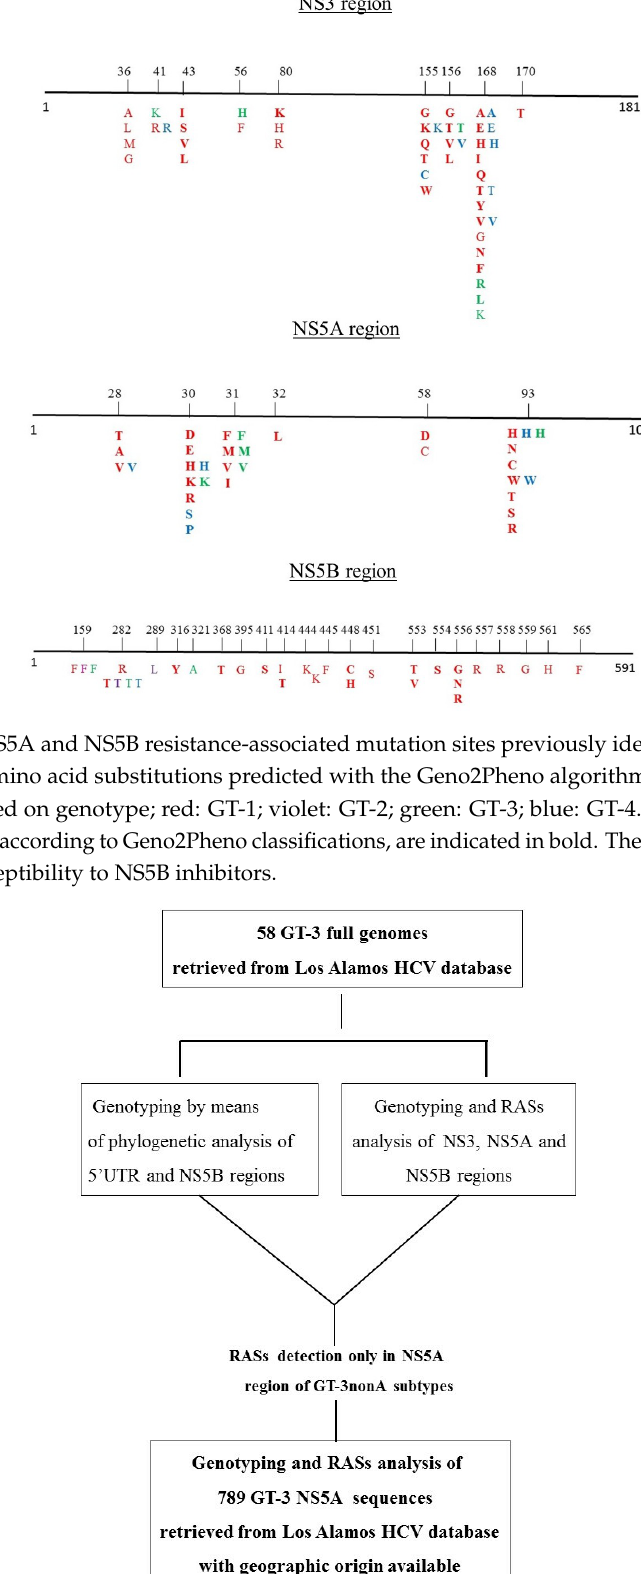
Figure 2. Schematic representation of the study design.